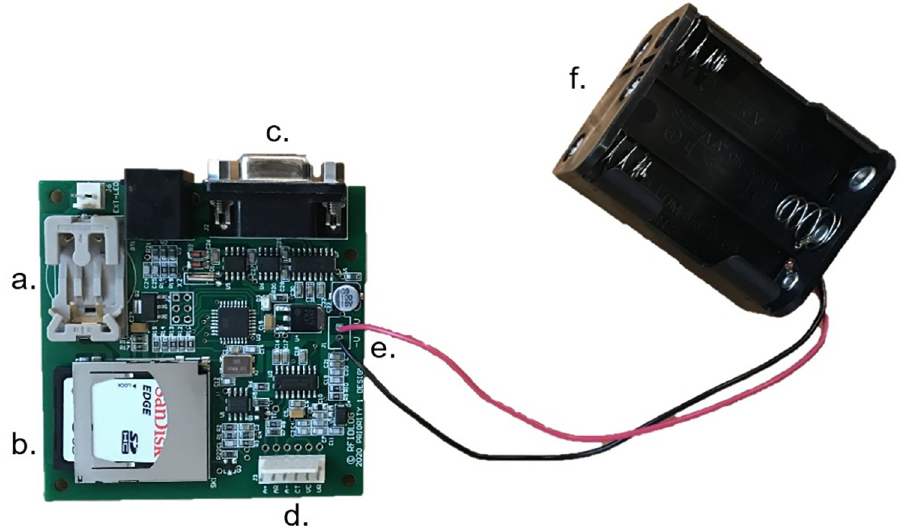
Fig 1. RFID logger (Priority 1 Designs; Melbourne, Australia). Components include battery casing for a CR2032 3V lithium that powers the units internal clock (a), SD card for storing RFID reads (b), serial port DBC computer connection (c), external antenna port (d), and an external battery pack for a power source to support unit (f), soldered directly to the power input